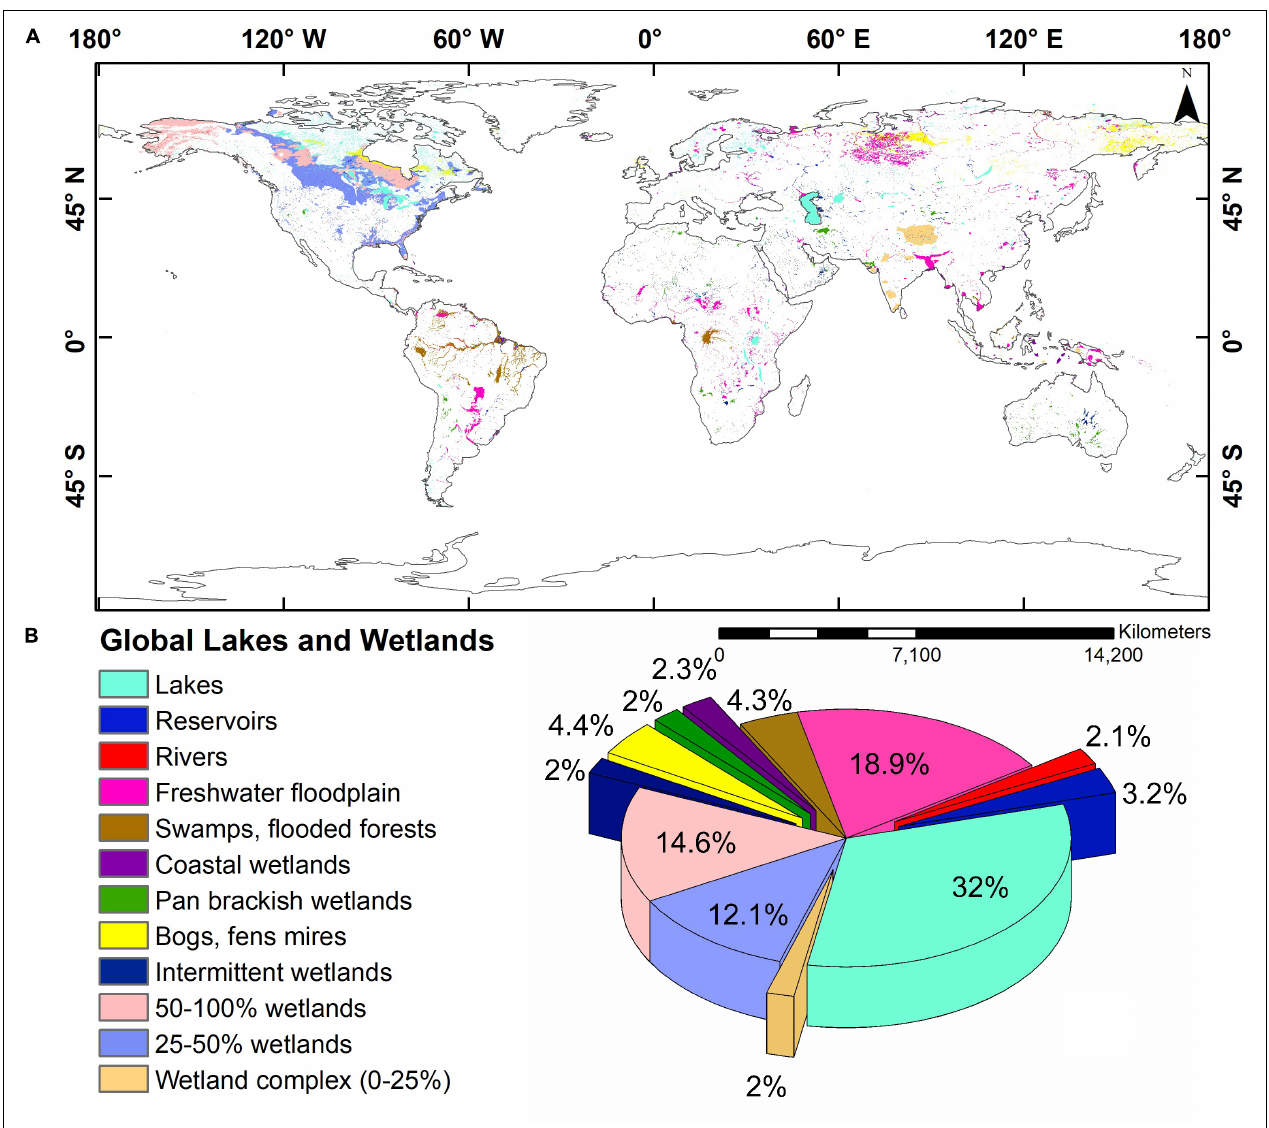
FIGURE 1 | (A) Spatial distribution of Global Lakes and Wetlands – GLWD 3 (Lehner and Doll, 2004). (B) Average percentage contribution of GLWD classes from Surface Water Microwave Product Series (SWAMPS) data to global surface inundation between 1995 and 2015.